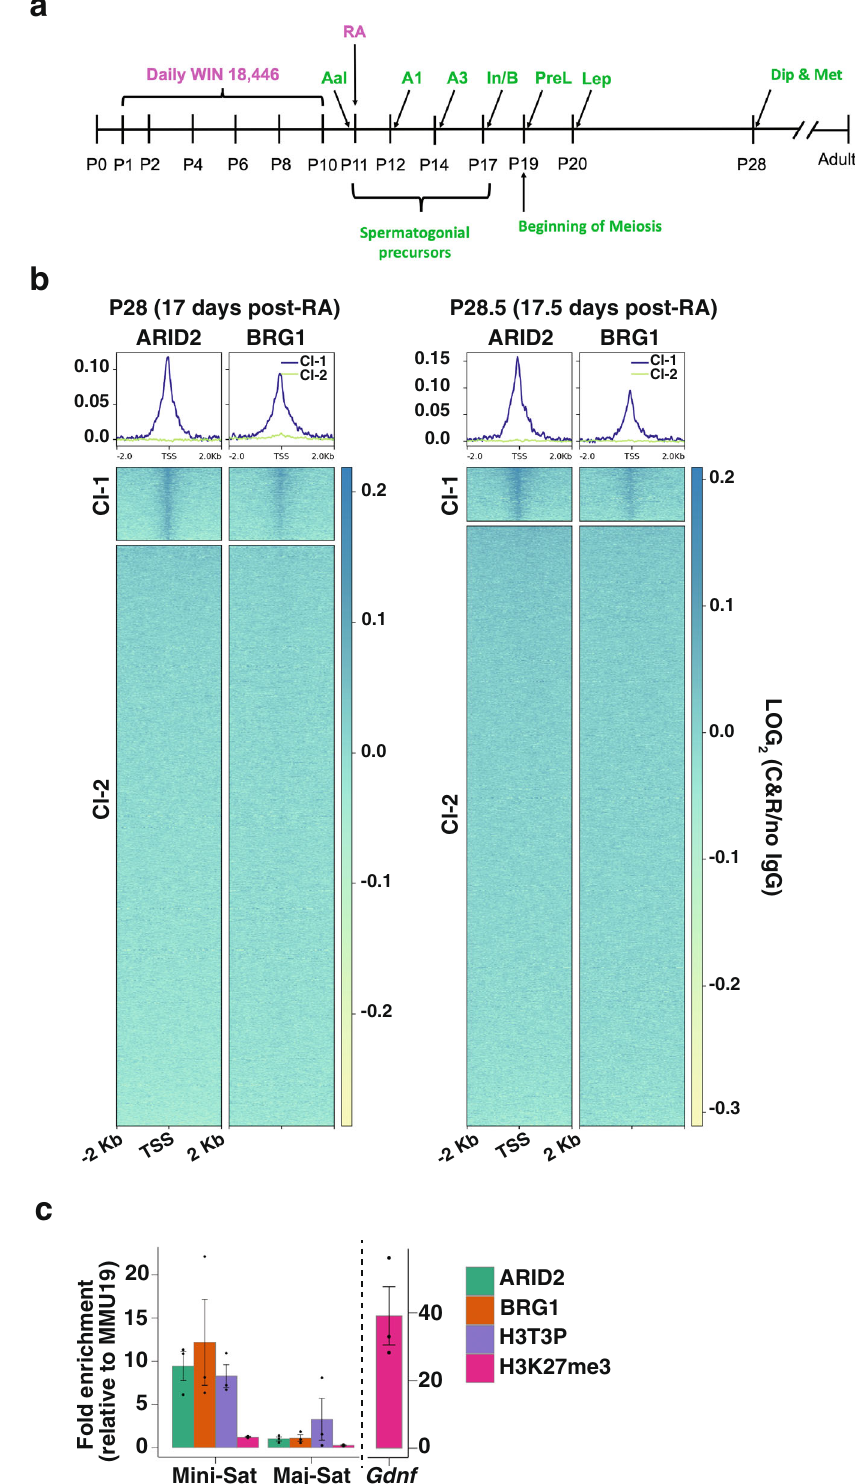
Fig. 4 Genome-wide associations of PBAF in spermatocytes. a Schematic illustrating protocol used to synchronize spermatogenesis using WIN 18,446 and retinoic acid (RA), b Heatmap displaying the average enrichment of ARID2 and BRG1 relative to no IgG control from spermatocyte populations isolated at P28 and P28.5. Enrichment is displayed over a 4 Kb window centered at transcription start sites (TSS ’ s) of RefSeq genes. K-means clusters (Cl-1 and 2) are based on ARID2 enrichment. c ChIP-qPCR analysis of ARID2, BRG1, H3T3P, and H3K27me3 enrichment at centromeric minisatellites (Mini-Sat) and pericentric major satellites (Major-Sat) repeats. Fold enrichment (y-axis) were calculated relative to known gene desert (MMU19) and were expressed as mean ± SEM. Dots (black) represent values obtained from three independent